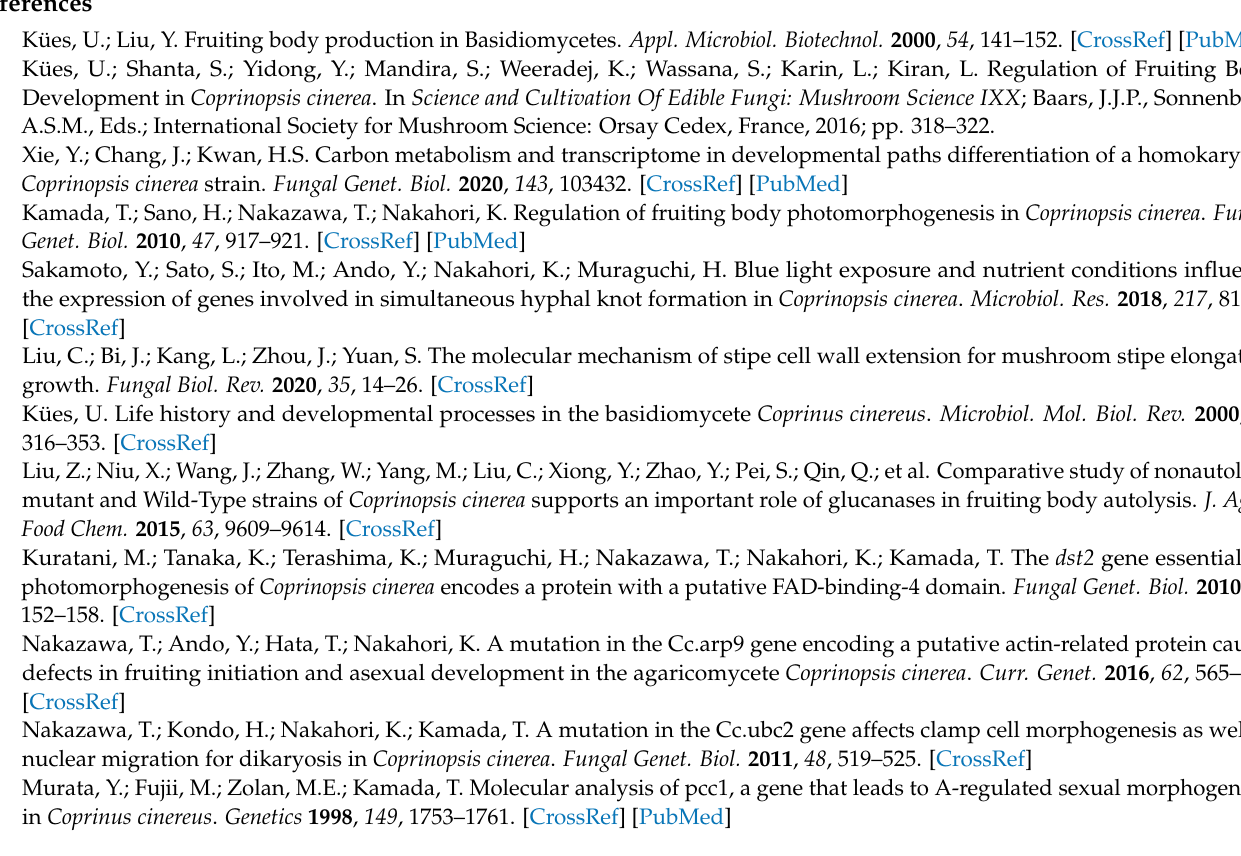
Figure S1: The chitinase activity of CcSakA gene silencing (SakAi) transformants, CcSakA phospho- mimicking mutant (SakAm) transformants, and mock